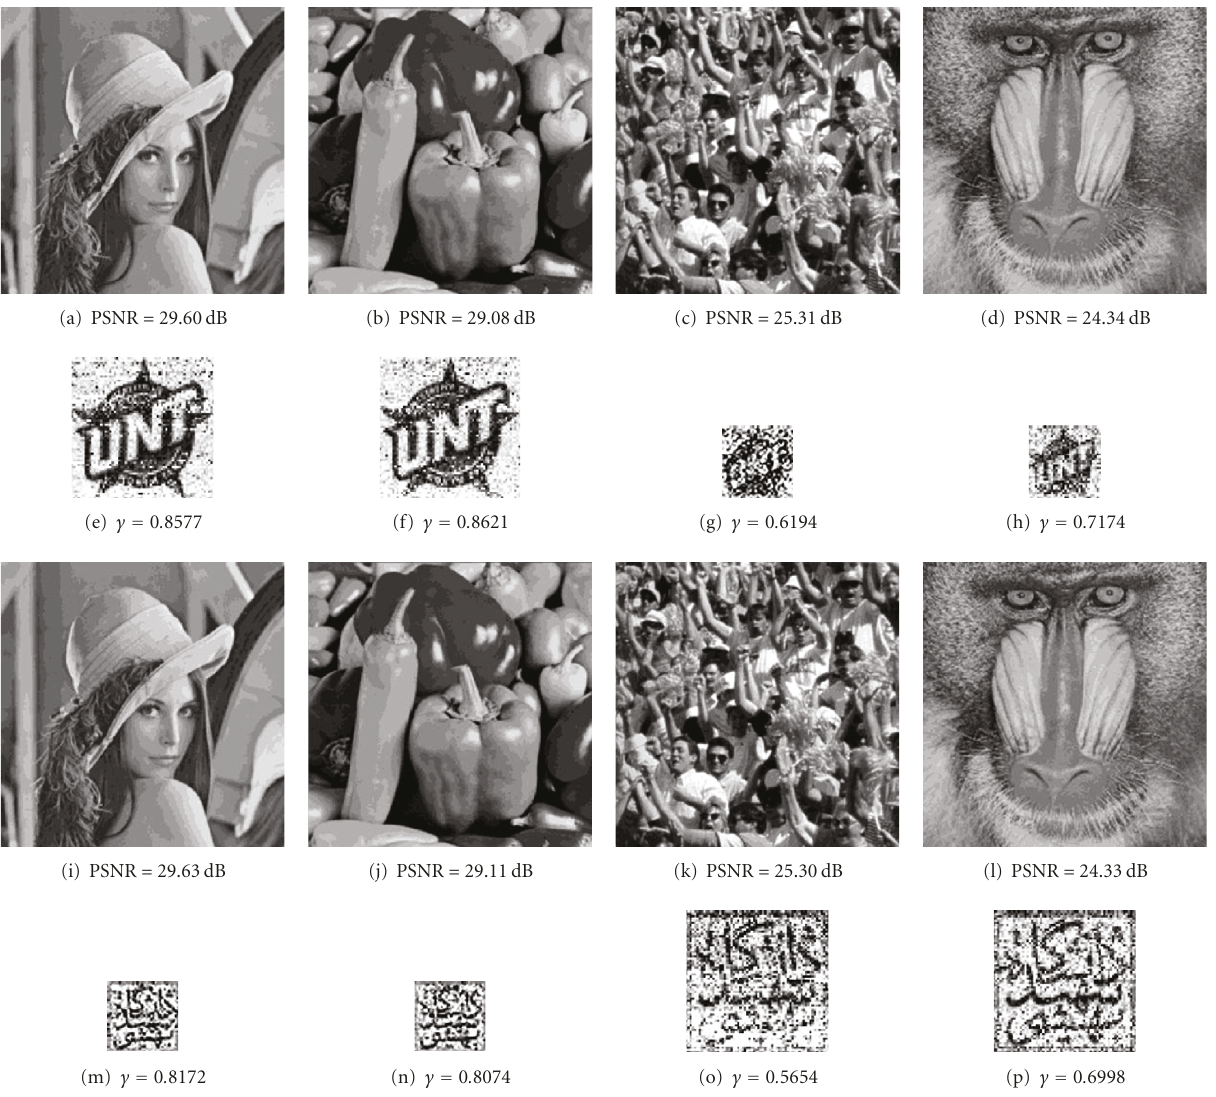
Figure 19: (a) and (b) Lena and Peppers watermarked images with 256 × 256 watermark image as shown in Figure 11(b) after performing Average filter with window size 5 × 5, (e) and (f) the extracted watermarks with size 256 × 256 from (a) and (b), respectively. (c) and (d) Crowd and Baboon watermarked images with 128 × 128 watermark image as shown in Figure 11(b) after performing Average filter, (g) and (h) the extracted watermarks with size 128 × 128 from (c) and (d), respectively. (i) and (j) Lena and Peppers watermarked images with 128 × 128 watermark image as shown in Figure 11(d) after performing Average filter, (m) and (n) the extracted watermarks with size 128 × 128 from (i) and (j), respectively. (k) and (l) Crowd and Baboon watermarked images with 256 × 256 watermark image as shown in Figure 11(d) after performing Average filter, (o) and (p) the extracted watermarks with size 256 × 256 from (k) and (l),